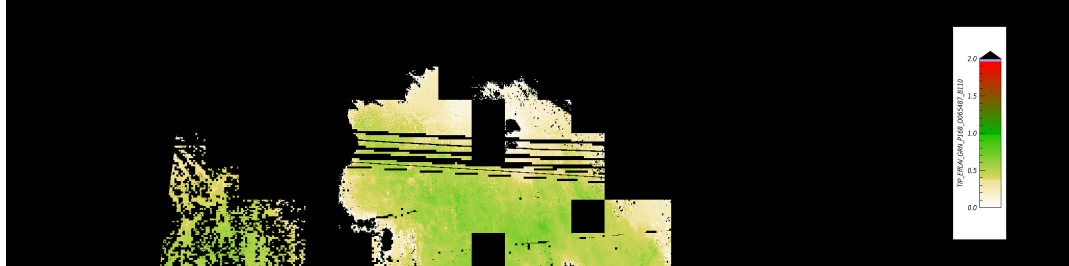
Figure 5. Example of the effect of missing lines in a derived product, here the leaf area index (LAI) for the particular date and time when an airborne field campaign was taking place in Kruger National Park in South Africa (the same P ATH 168, O RBIT 65487 and B LOCK 110 as for Figs. 1 and 2; see text for details). A large fraction of the MISR B LOCK is unavailable (depicted in black) due to the prevailing cloud cover on that particular date as well as the presence of missing lines. The color gradient (white, yellow, green, red) maps the LAI range [0.0,